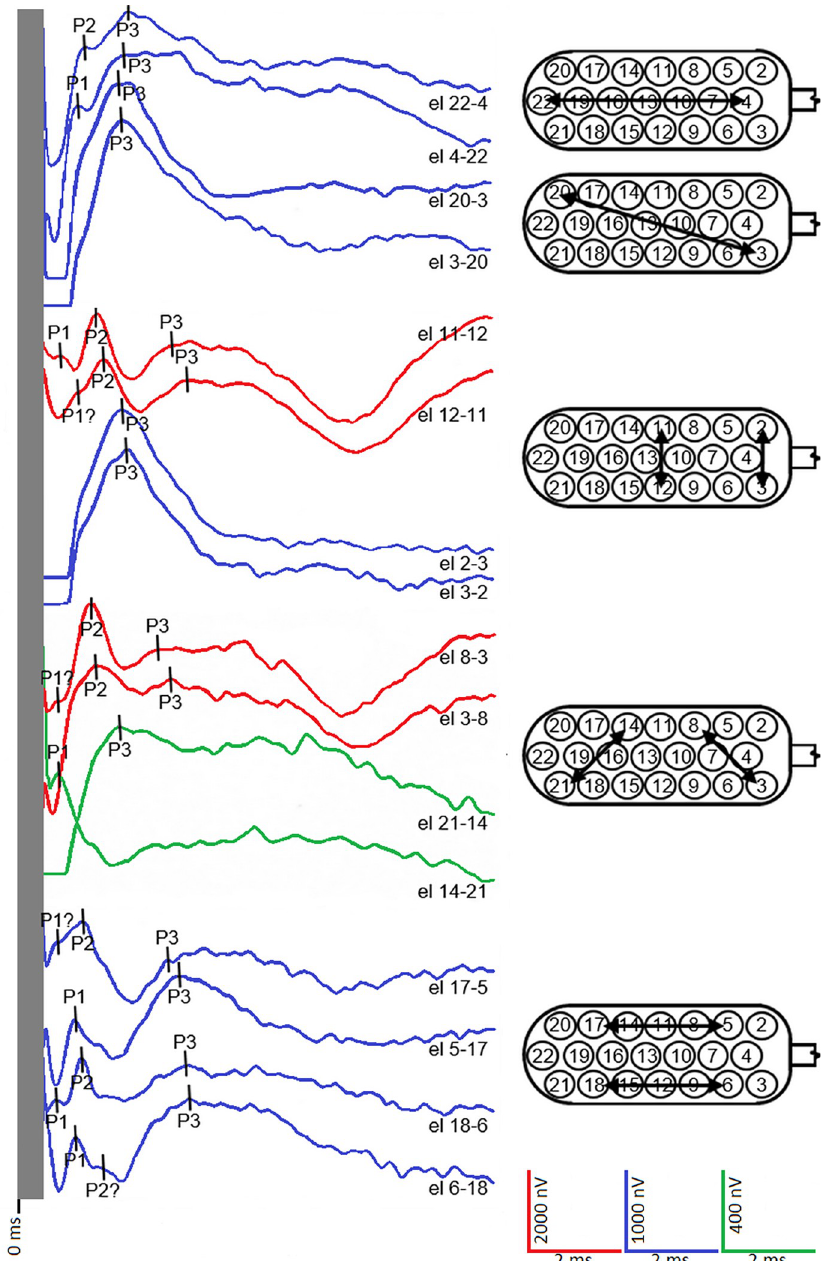
Fig 2. EABRs obtained with the cochlear protocol (CP) for patient CH7. For electrode combinations with wide stimulation arcs (e.g., 22–4, 3–20), the waveforms have a 1- or 2-peak morphology more frequently than a 3-peak morphology. For electrode combinations with narrower stimulation arcs (e.g., 11–12, 8–3), the waveforms have a 3-peak morphology when associated with auditory sensation. Stimulation artifacts present in the first 0.5 ms of recording have been eliminated. el,